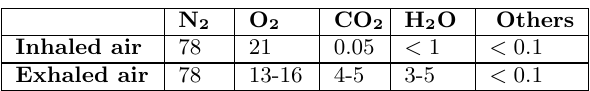
Table 1: The composition percentage of exhaled and inhaled air